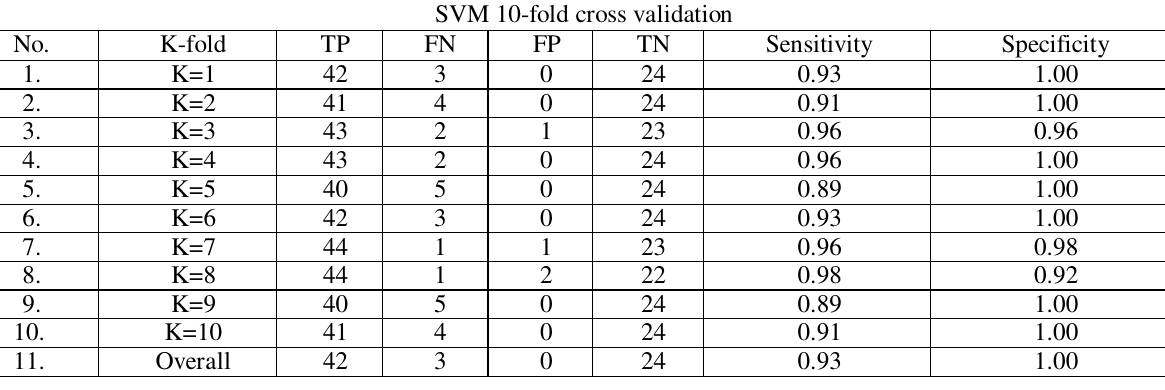
Table 5: 10-fold cross validation of SVM